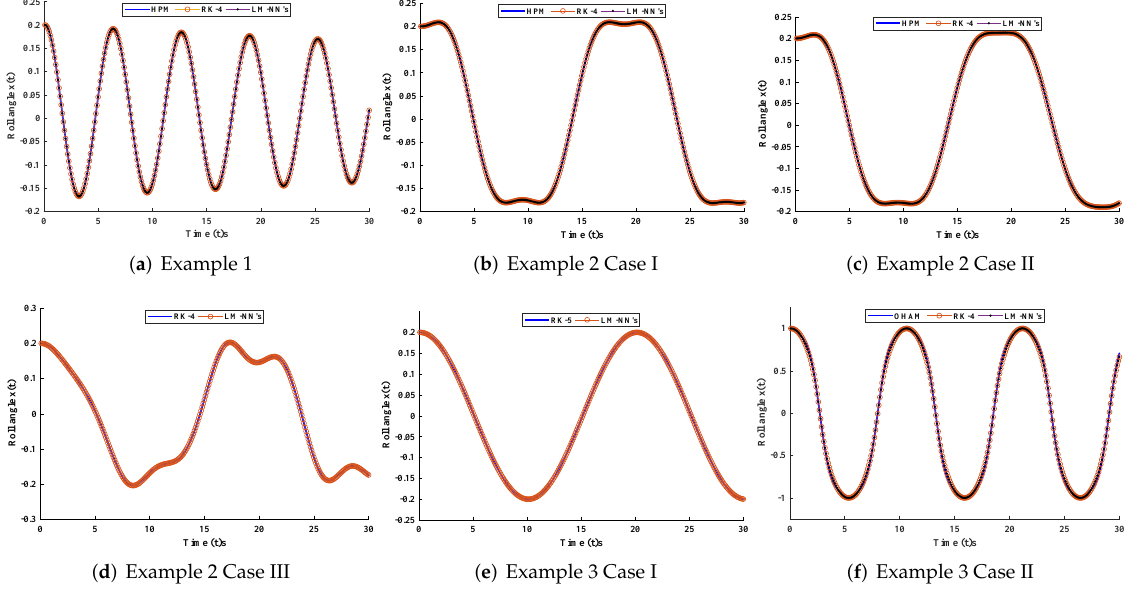
Figure 6. Comparison of approximate solutions with the numerical solver (RK-4), HPM, and OHAM for different examples of the rolling motion of